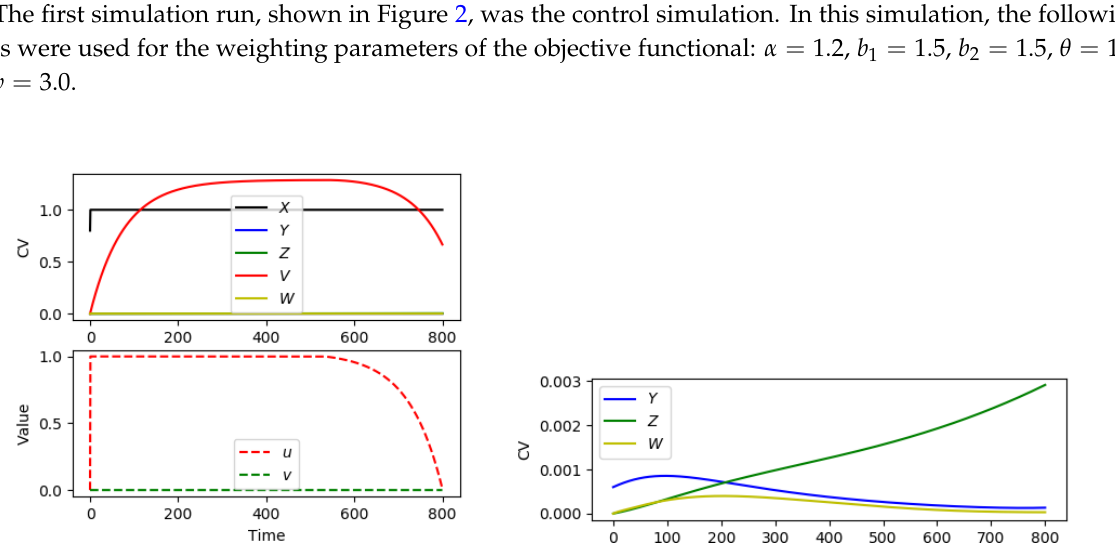
Figure 2. Numerical Optimal Control and Treatment Simulation Results - Control